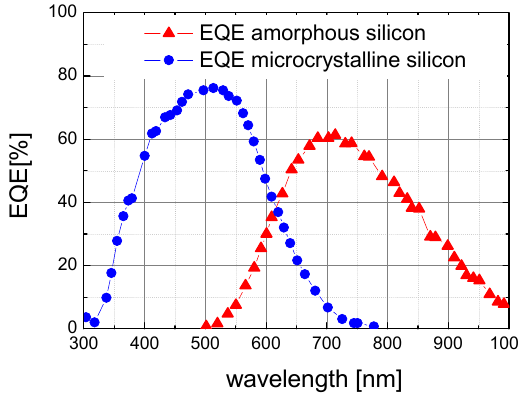
Figure 15. External quantum efficiencies of the two junctions of a micromorph tandem cell [53]. High energy photons are nearly completely absorbed in the top a-Si:H cell, low energy photons are transmitted to the bottom μ c-Si cell and are absorbed there. For wavelengths above  λ = 550 nm, the EQE of the top cell is limited by the low absorption